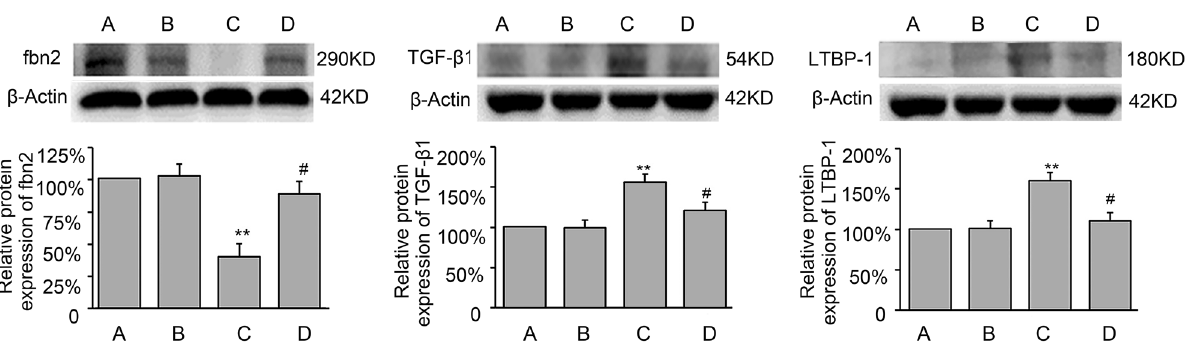
Figure 8. Measurement of fbn2, Tgf-β1 and LTBP-1 expression at protein levels using Western blot in the retina of mice in NC, AAV-NC, AAV-sh-fbn2 and Fbn2-0.75 μg group (all groups n = 9). Data are shown as mean ± SEM. ** P < 0.001 all other groups versus AAV-NC group; # P < 0.05 all other groups versus AAV-sh-fbn2 group. Original blots are presented in Supplementary Fig. 2–5. A: NC group, B: AAV-NC group, C: AAV- sh-fbn2 group, D: Fbn2-0.75 μg group. (** P < 0.001 compared with the AAV-NC group; # P < 0.05 compared with the AAV-sh-fbn2 group). NC group: Animals without intervention. AAV-NC group: Animals with an intravitreal injection of AAV empty vector and without any further treatment. AAV-sh-fbn2 group: Animals with an intravitreal injection of AAV-sh-fbn2 and without any further treatment. Fbn2-0.30 μg group: Animals with an intravitreal injection of AAV-sh-fbn2, followed by an intravitreal injection of fbn2 recombinant protein in a dose of 0.30 μg. Fbn2-0.75 μg group: Animals with an intravitreal injection of AAV-sh-fbn2, followed by an intravitreal injection of fbn2 recombinant protein in a dose of 0.75 μg. Fbn2-1.5 μg group: Animals with an intravitreal injection of AAV-sh-fbn2, followed by an intravitreal injection of fbn2 recombinant protein in a dose of 1.50 μg. Fbn2-3.0 μg group: Animals with an intravitreal injection of AAV-sh-fbn2, followed by an intravitreal injection of fbn2 recombinant protein in a dose of 3.00